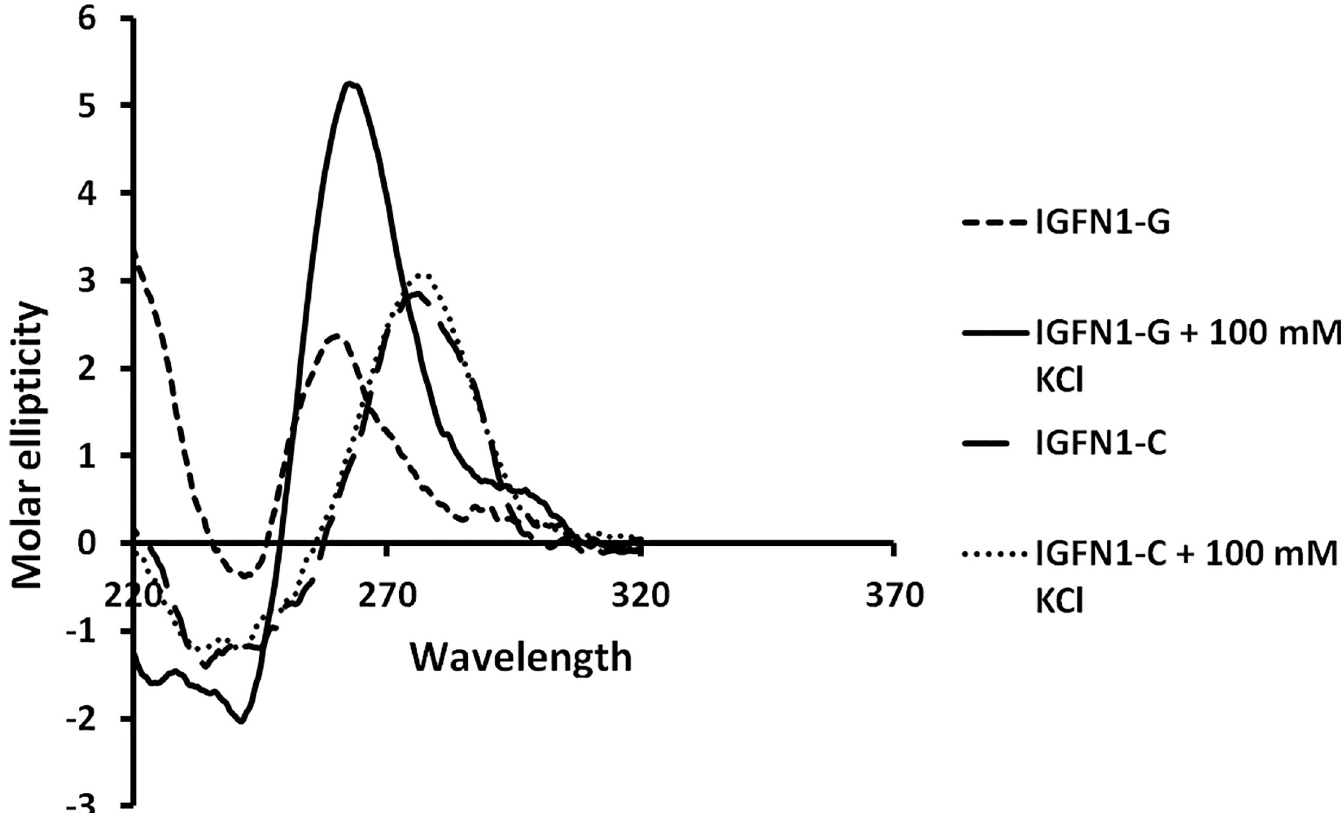
Fig 4. CD spectroscopy. Secondary structure study by circular dichroism showing the formation of G-quadruplex in the IGFN1-G and IGFN1-C in presence and absence of 100 mM